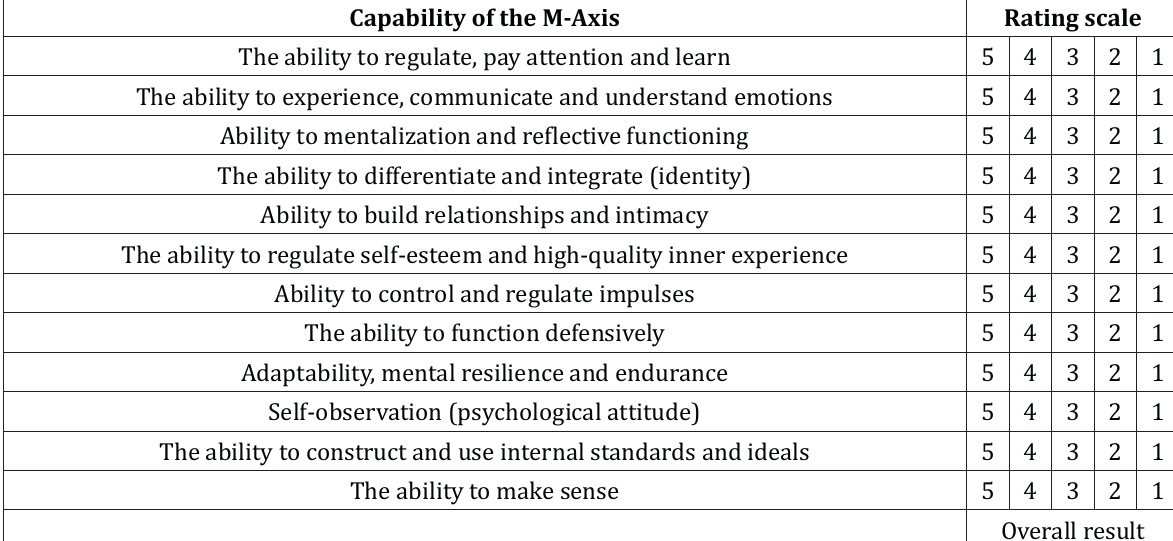
Table 2. Capacity assessment on the M axis (source: [3]) Capability of the